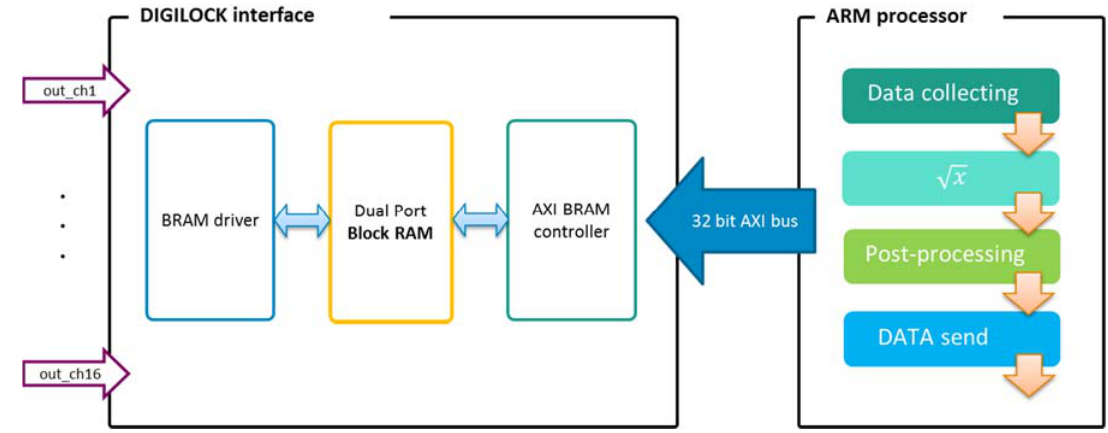
Figure 3. Programmable logic interface and ARM processor tasks.